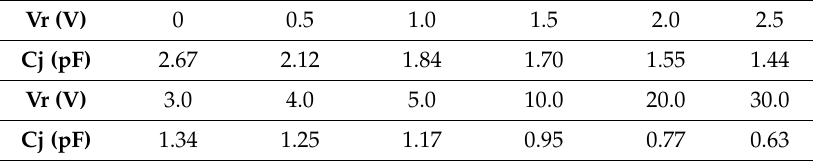
Figure 8. Simplified equivalent varactor Circuit. Table 1. Capacitance vs reverse voltage of SMV 1405-079LF.